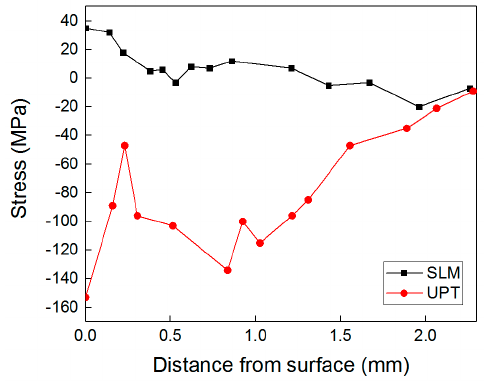
Figure 5. Residual stress in the specimen before and after UPT.